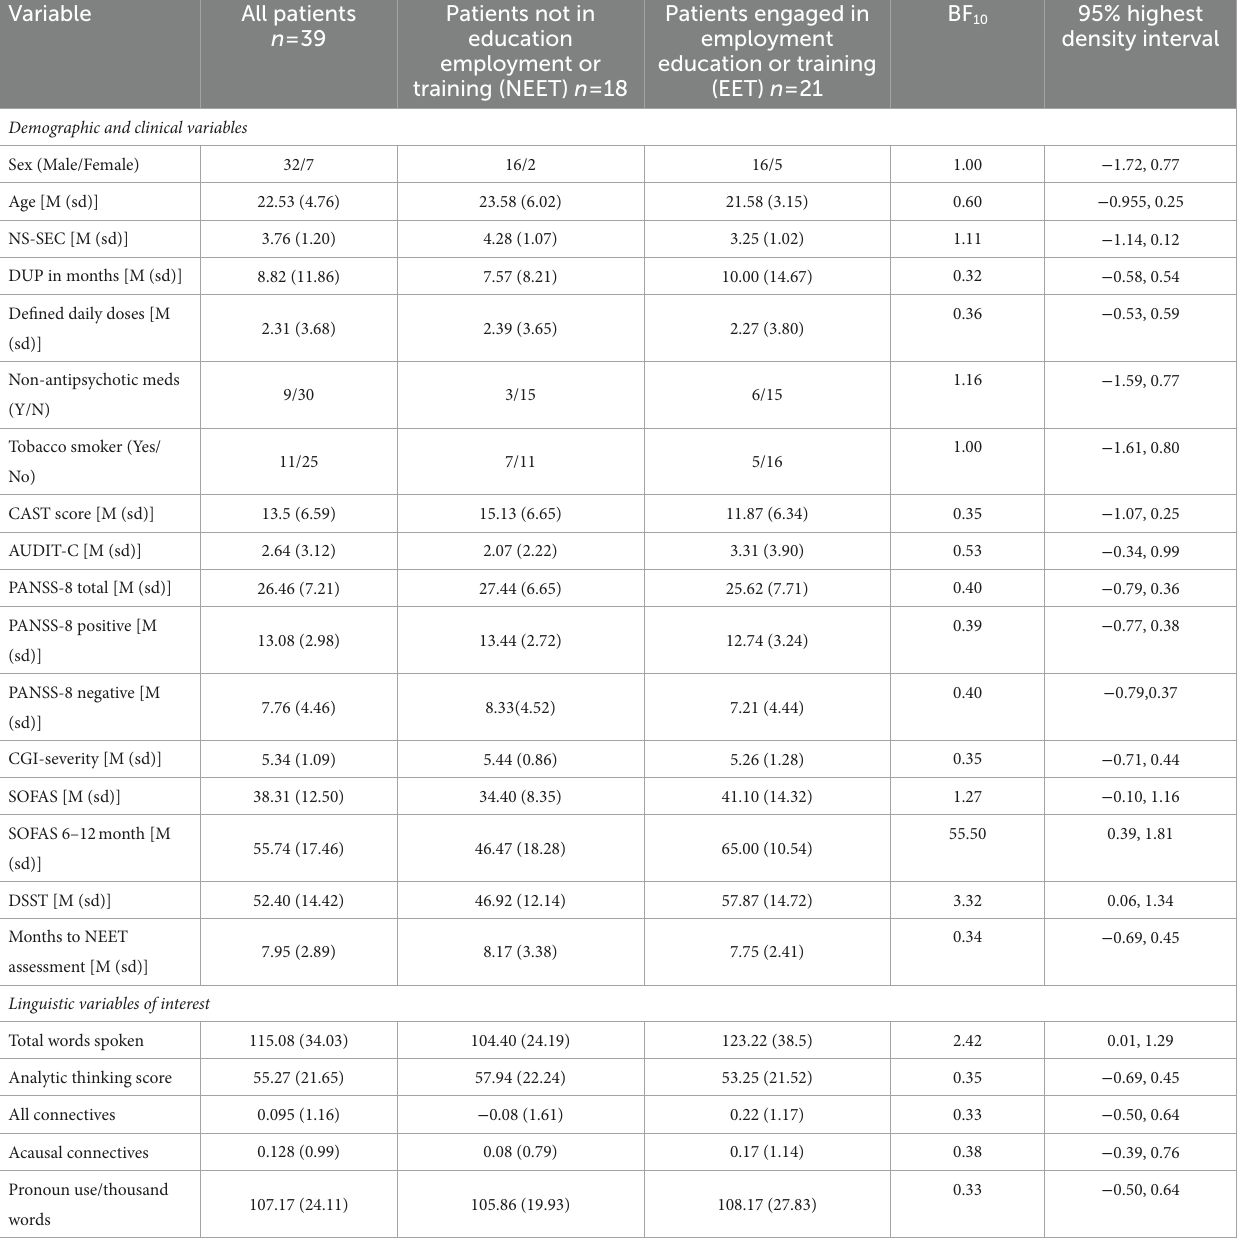
TABLE 1 Demographic and linguistic characteristics of sample.